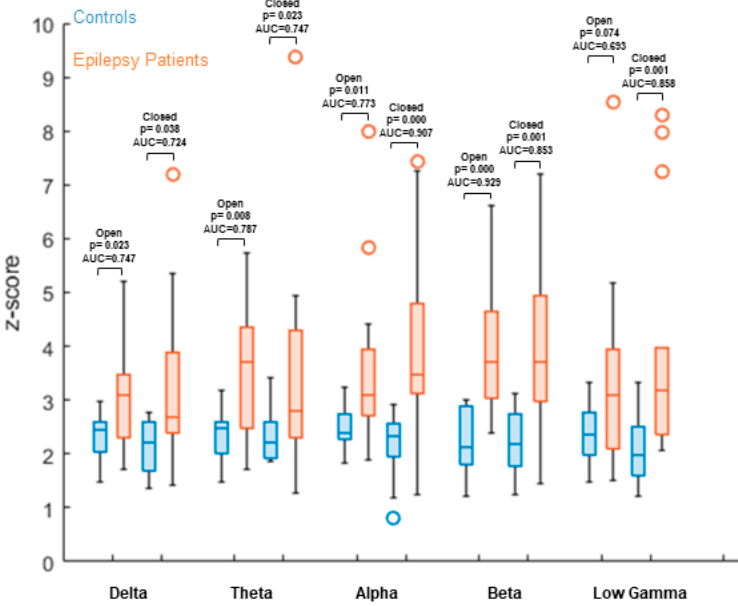
Table 4 . AUC with conditions EO/EC compared to patients.